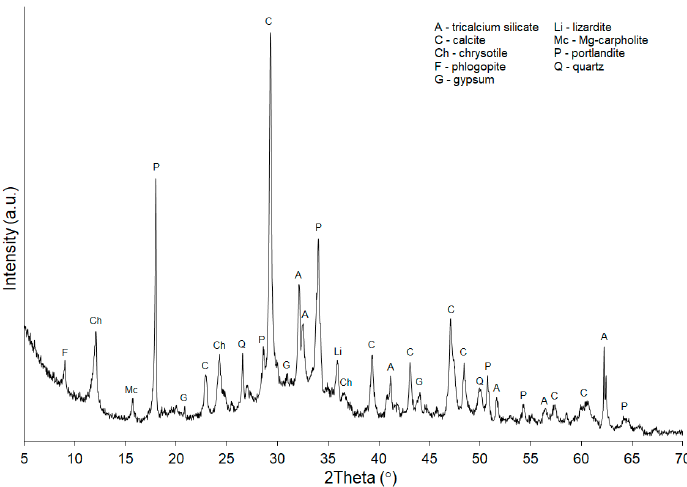
Figure 1. X-ray diffraction (XRD) pattern of a cement-asbestos waste board.